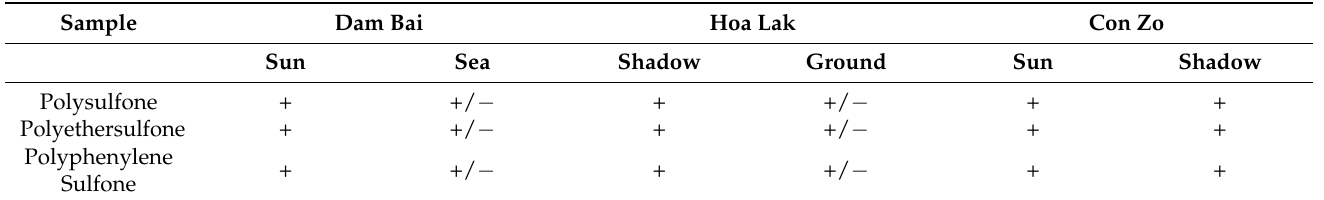
the sample is partially deformed; “ − ” the sample is destroyed. Exposure time—3